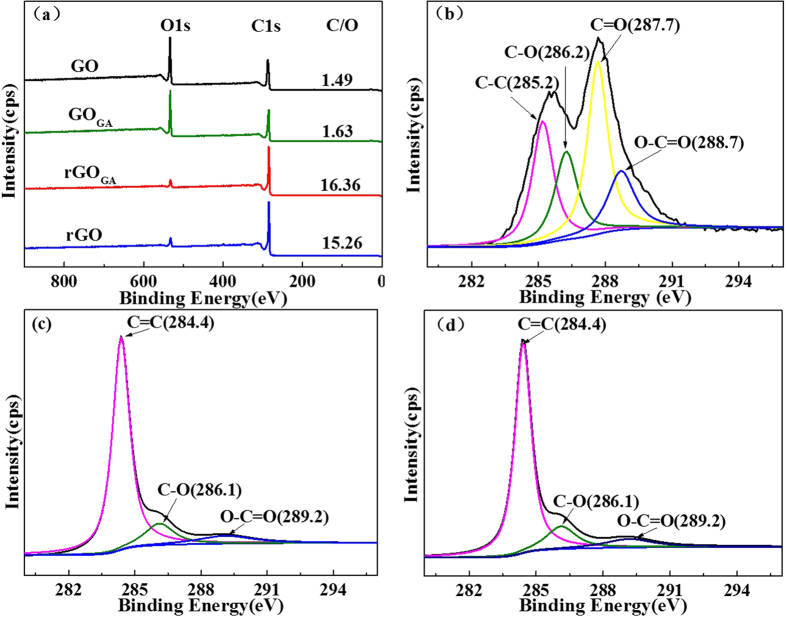
XPS survey spectra (a), C1s XPS spectra of GO (b), rGOGA (c) and rGO (d).